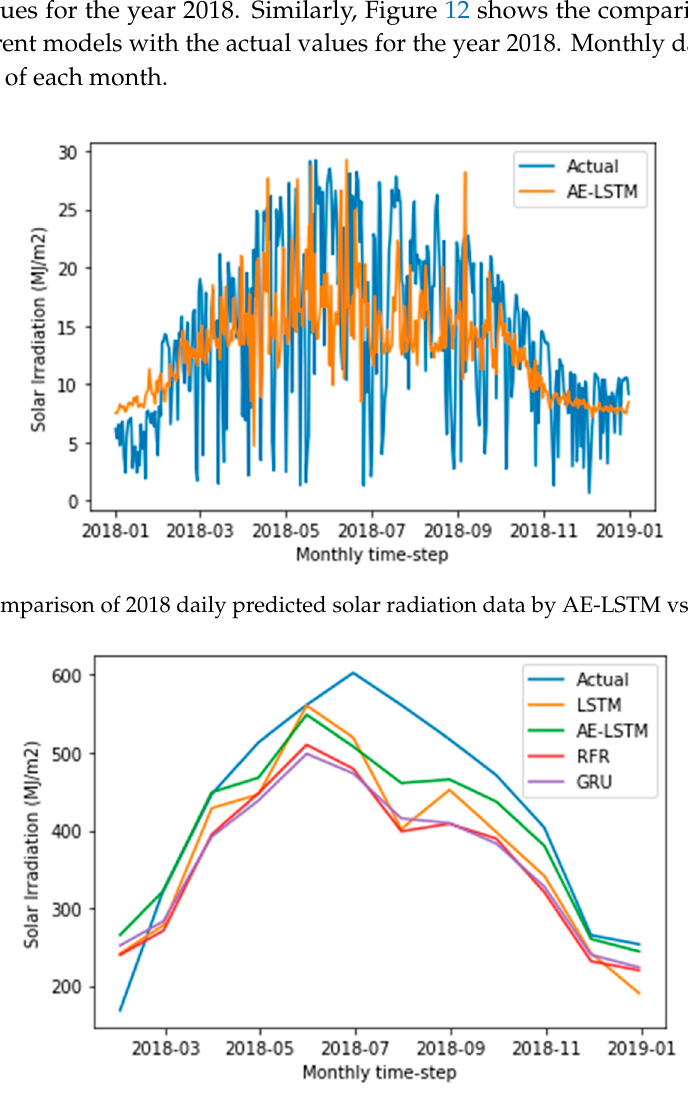
Figure 12. Comparison of predicted data by di ff erent models vs. the actual values for 2018 by monthly period.